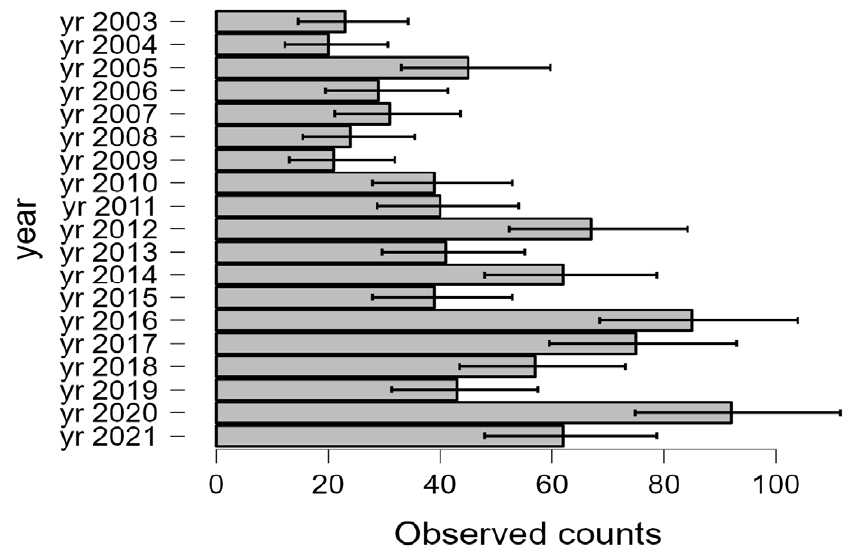
Figure 4. Species richness (S) multinomial test plot for 2003–2021 time interval in ex-arable grassland from Gr ă dinari.